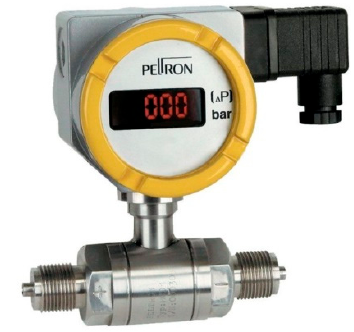
Figure 6. The PXWD di ff erential pressure transducer [35].